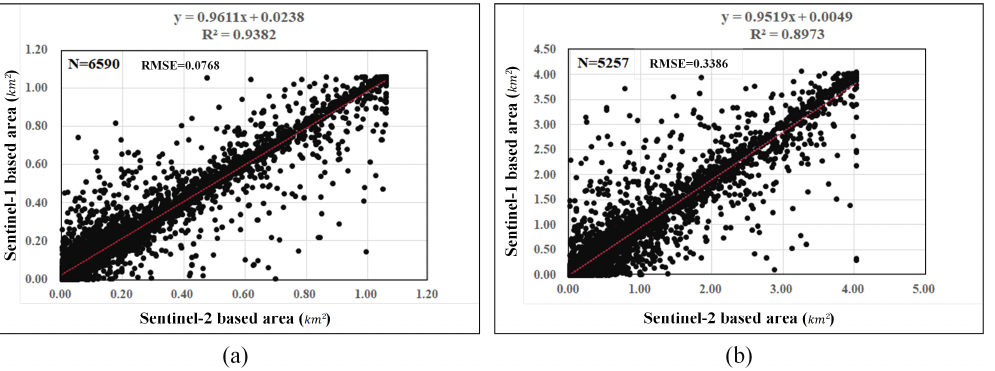
Figure 8. The correlation between water extraction results from the Sentinel-2 image and Sentinel-1 image. ( a ) Correlation result of Dongting Lake; ( b ) correlation result of Poyang Lake.